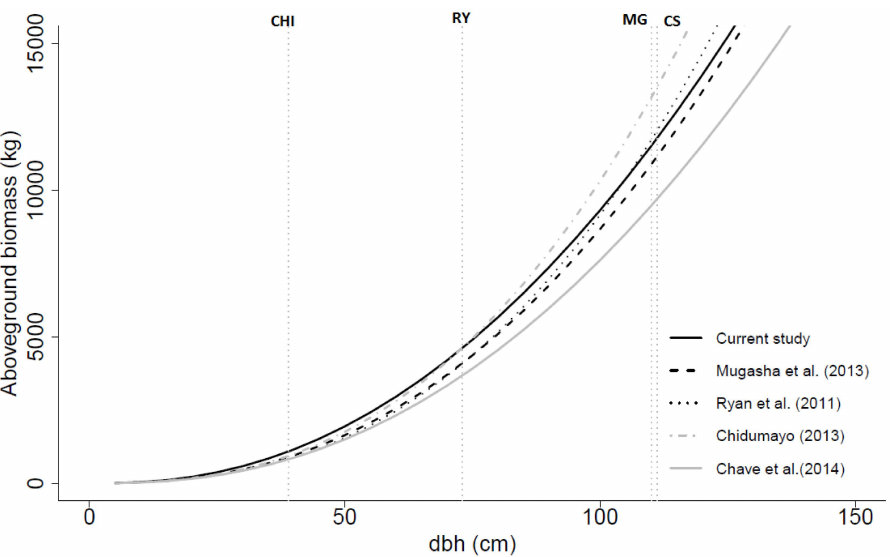
Figure 5. Aboveground biomass (dry weight) over dbh based on the general models developed in this study (with dbh and ht as independent variables), by Mugasha et al. [21] (with dbh and ht as independent variables), by Ryan et al. [4] (with dbh as only independent variable), by Chidumayo [18] (with dbh only as independent variable) and by Chave et al. [39] (with dbh, ρ , and ht as independent variables). CHI, RY, MG and CS are the maximum dbh values for the data used in the models developed by Chidumayo [18], Ryan et al. [4], Mugasha et al. [21] and current study, respectively.